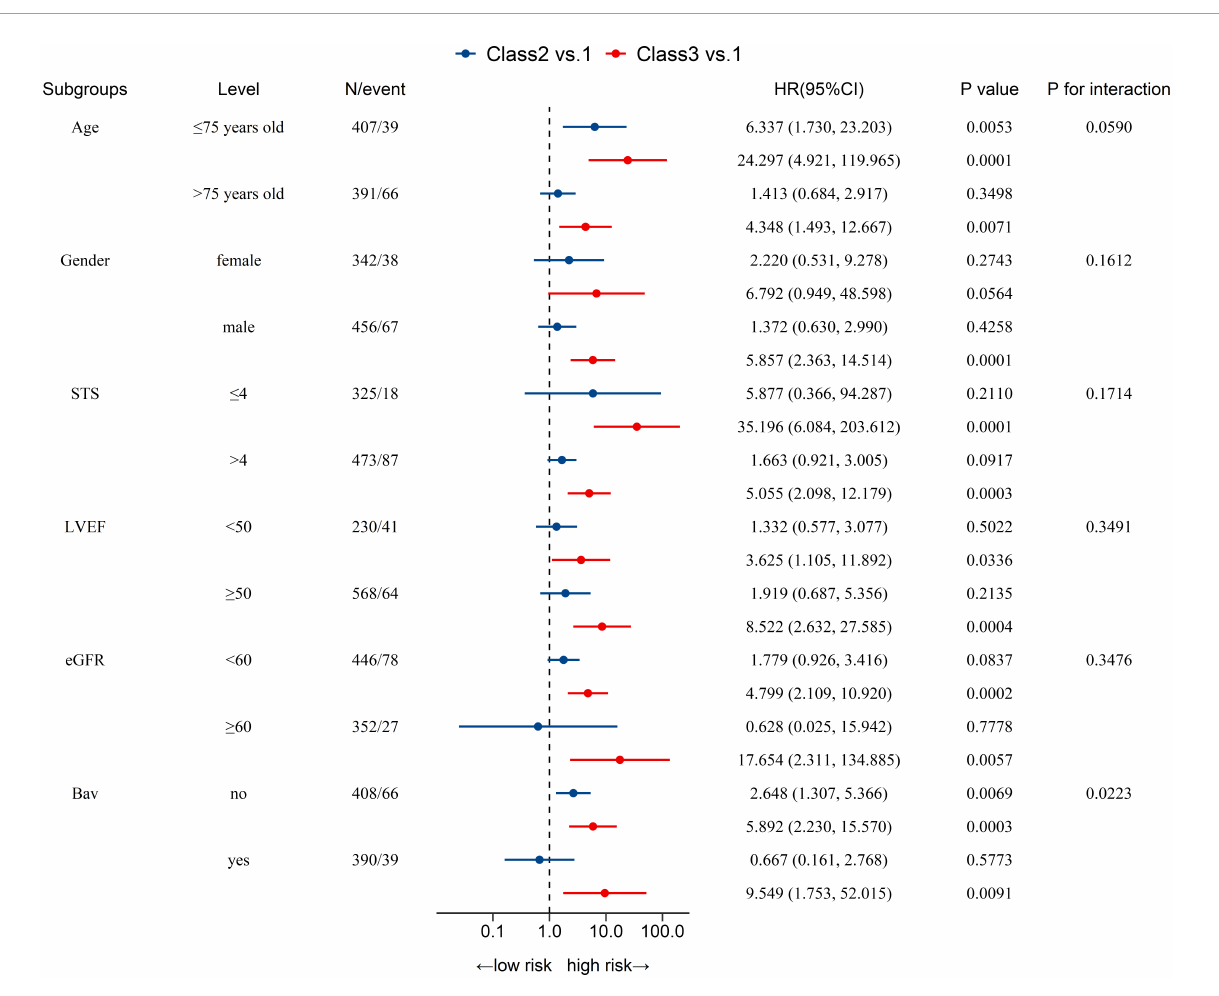
FIGURE3 Association between trajectories of NT-proBNP and 5-year all-cause mortality after TAVR in prespecified